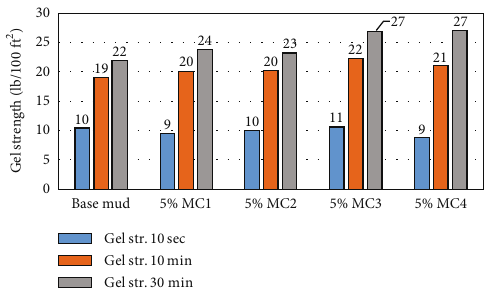
Figure 7: Gel strengths as function of adding 5% of di ff erent cuttings to the base mud.